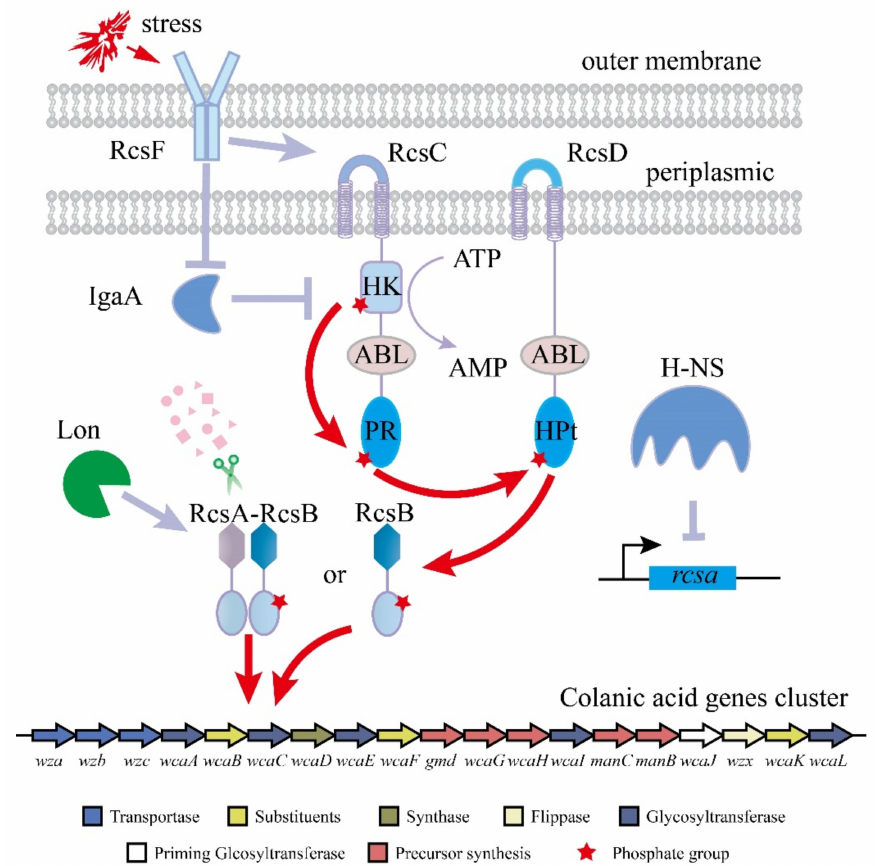
Figure 1. The RCS phosphorylation system. RcsF senses the external stimulus and promotes the phosphorylation of RcsC. Through RcsC and RcsD, the phosphorylation signal is transmitted to RcsB. The phosphorylated RcsB binds to the colanic acid gene cluster alone or after binding to RcsA to promote the transcription of the colanic acid gene